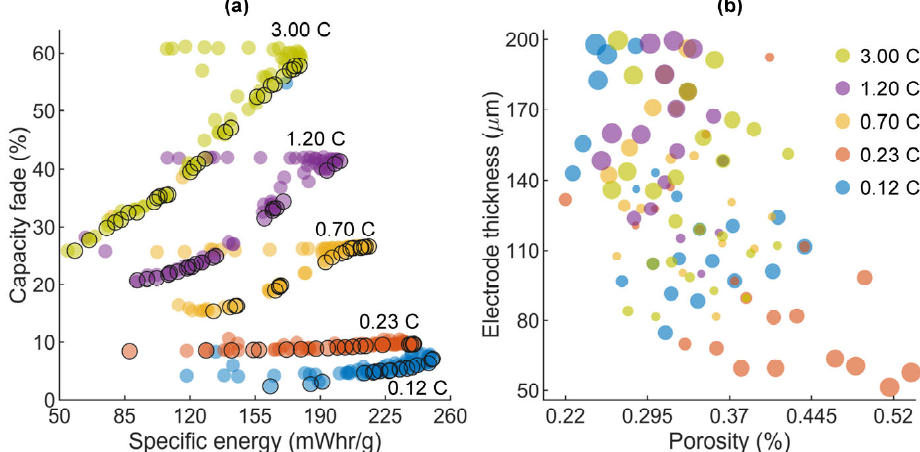
Figure 7. Summary of optimization results. ( a ) Distribution of the initial sampling plan and Bayesian optimization samples in the objective space for the charge–discharge scenarios 0.12 C charge–0.23 C discharge, 0.23 C charge–0.23 C discharge, 0.7 C charge–0.23 C discharge, 1.2 C charge–0.23 C discharge, and 3 C charge–0.23 C discharge. ( b ) Distribution of the optimal designs in the design space. The size of the markers vary according to the specific energy of the design, e.g., large circles correspond to cells with high specific energy and vice versa.